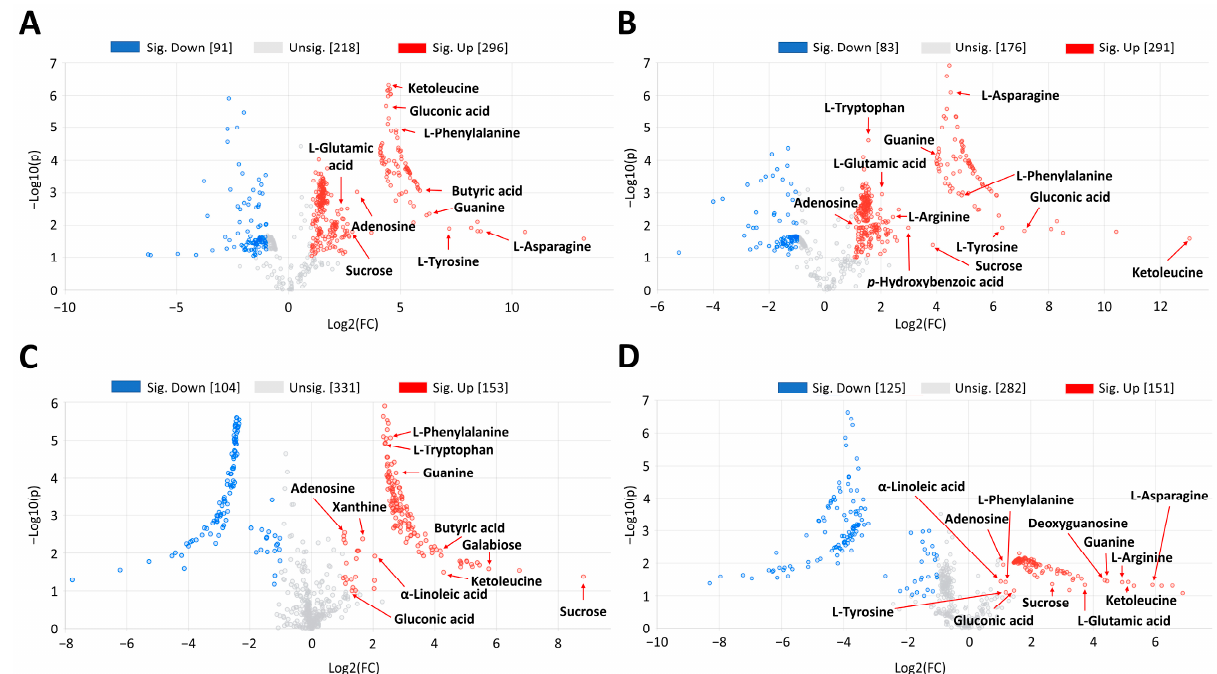
Figure 5. Volcano plots of metabolomic data obtained by UPLC-MS-QTOF comparing V. planifolia × V. pompona (PL × PO) and V. pompona × V. planifolia (PO × PL) hybrids versus V. planifolia (PL) under water stress exposure. ( A ) PL × PO / PL at 20 days of water stress exposure. ( B ) PO × PL / PL at 20 days of water stress exposure. ( C ) PL × PO / PL at 40 days of water stress exposure. ( D ) PO × PL / PL at 40 days of water stress exposure. Some differential metabolites (fold change >2) that are tentatively identified are shown in each subfigure; the complete list is in Tables S3–S6.